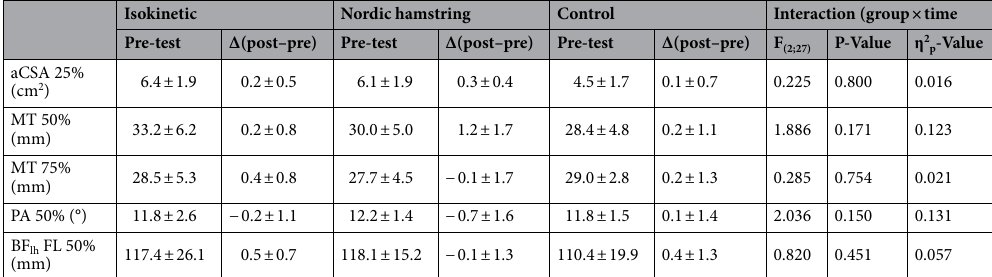
Table 3. Biceps femoris long head morphology parameters and pre- and post-test. MT, muscle thickness; aCSA, anatomical cross-sectional area; PA, pennation angle; BF lh , biceps femoris long head; FL, fascicle length.